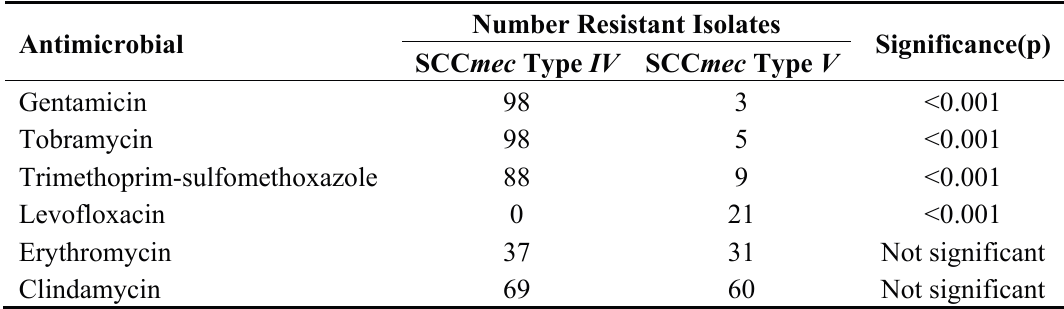
Table 1. Statistical significance of antimicrobial resistance according to SCC mec type detected